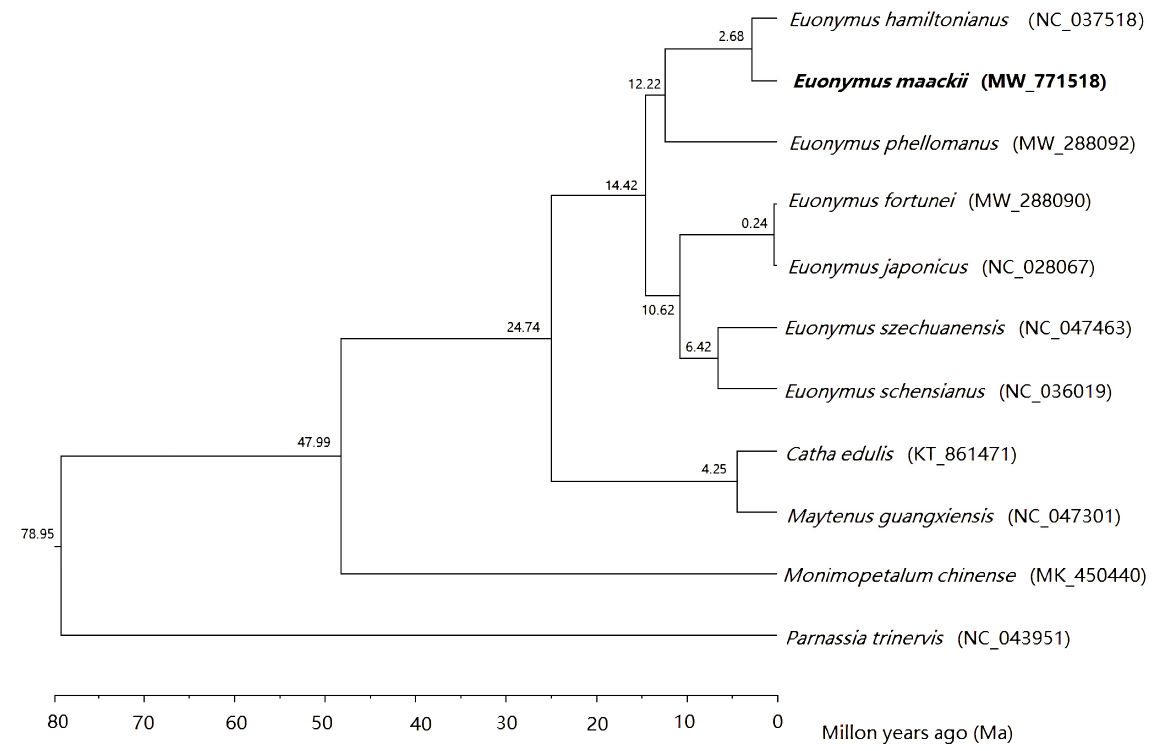
Figure 7. Estimation of divergence time based on the whole chloroplast